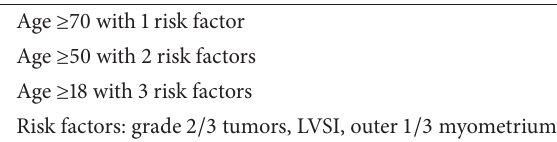
Table 6: High-intermediate risk endometrial cancer patients. Age ≥ 70 with 1 risk factor Age ≥ 50 with 2 risk factors Age ≥ 18 with 3 risk factors Risk factors: grade 2/3 tumors, LVSI, outer 1/3